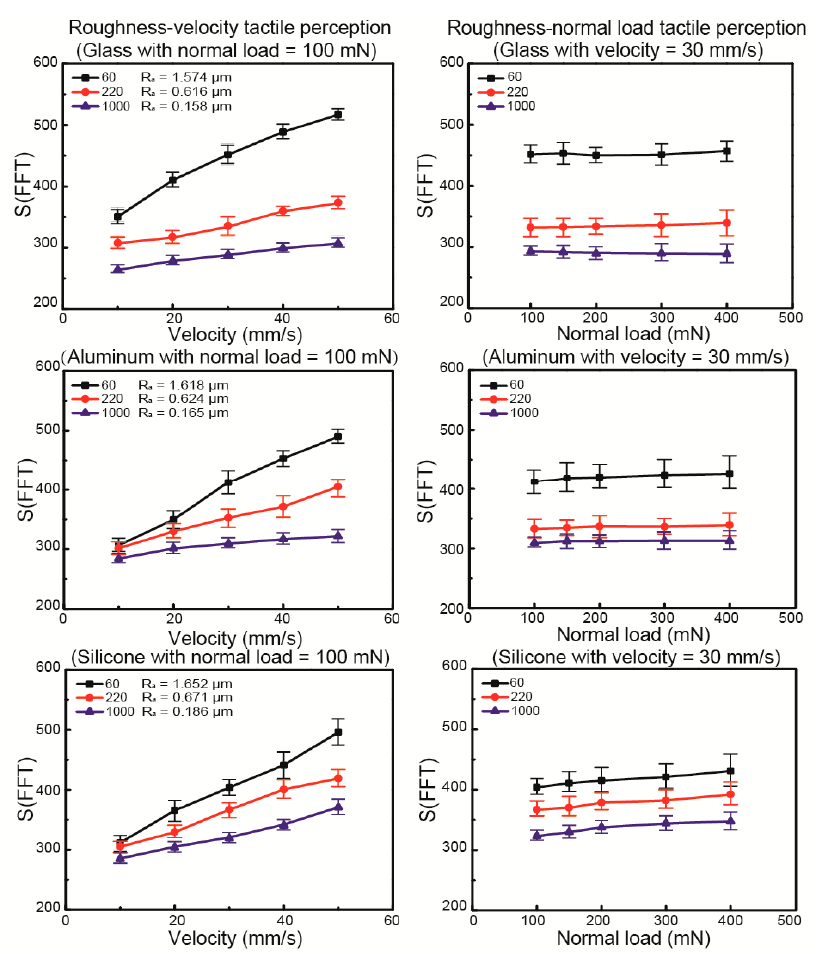
Figure 5. Glass, aluminum, and silicone roughness and hardness tactile perception as a function of velocity and normal load.